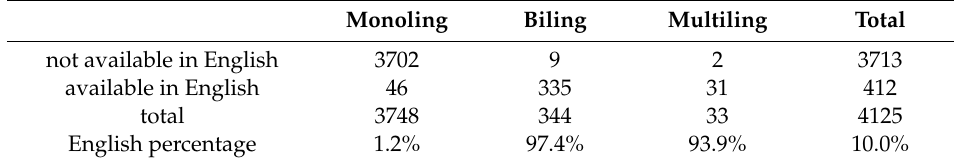
Table A20. English language availability (fr).